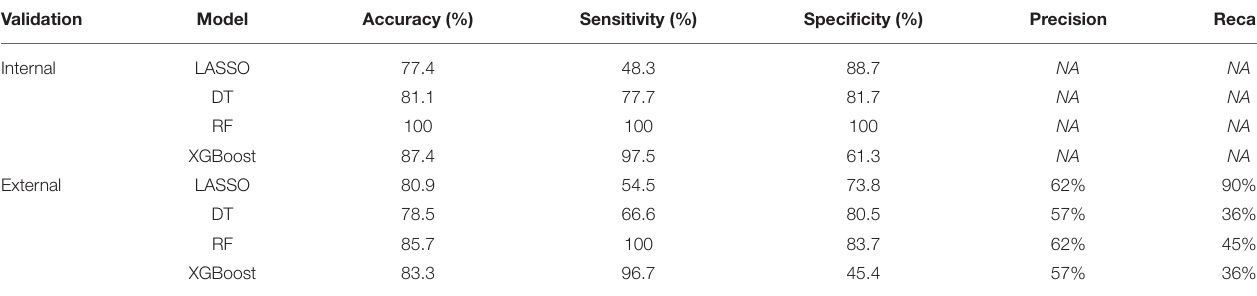
TABLE 3 | LASSO and tree-based model performance and validation.